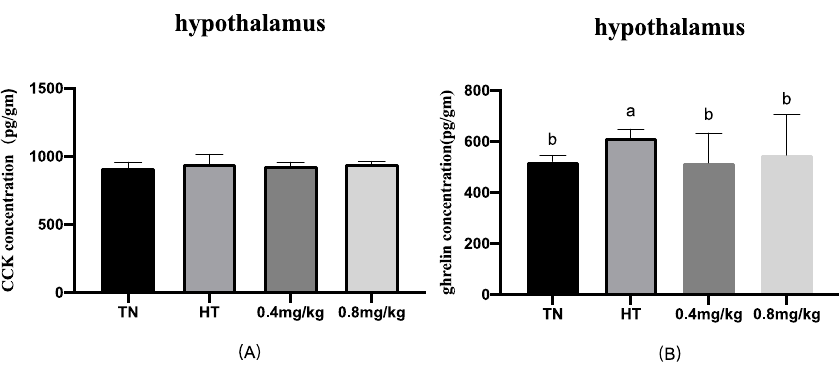
Figure 1. Effects of chromium supplementation on gastrointestinal peptides in the hypothalamus. ( A ) CCK concentration in hypothalamus; ( B ) ghrelin concentration in hypothalamus. a,b Means values between the column with different letters differ significantly.